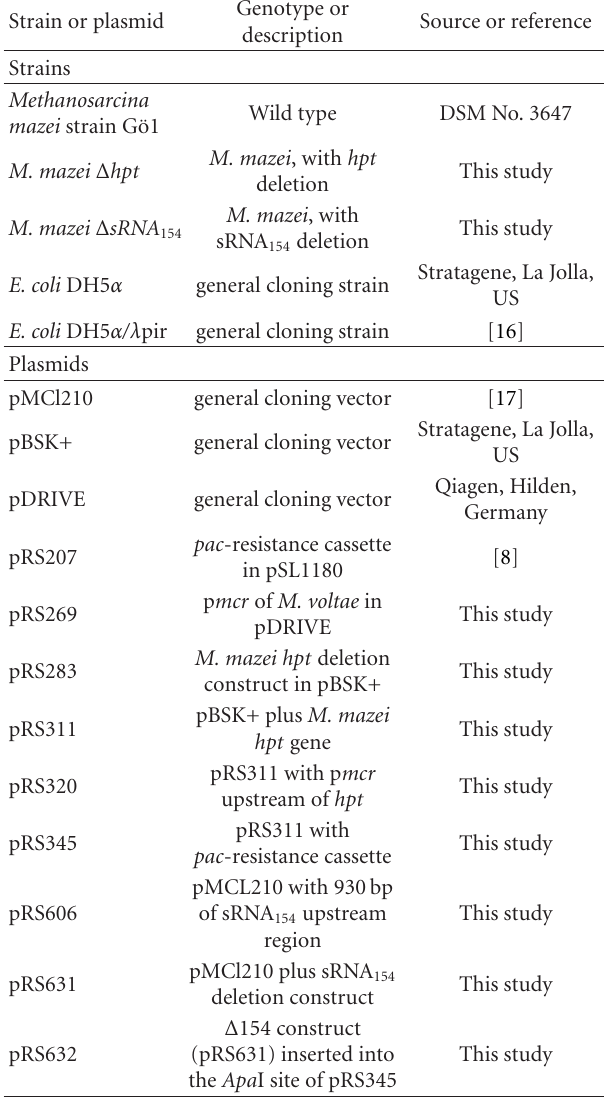
Table 1: Strains and plasmids used in this